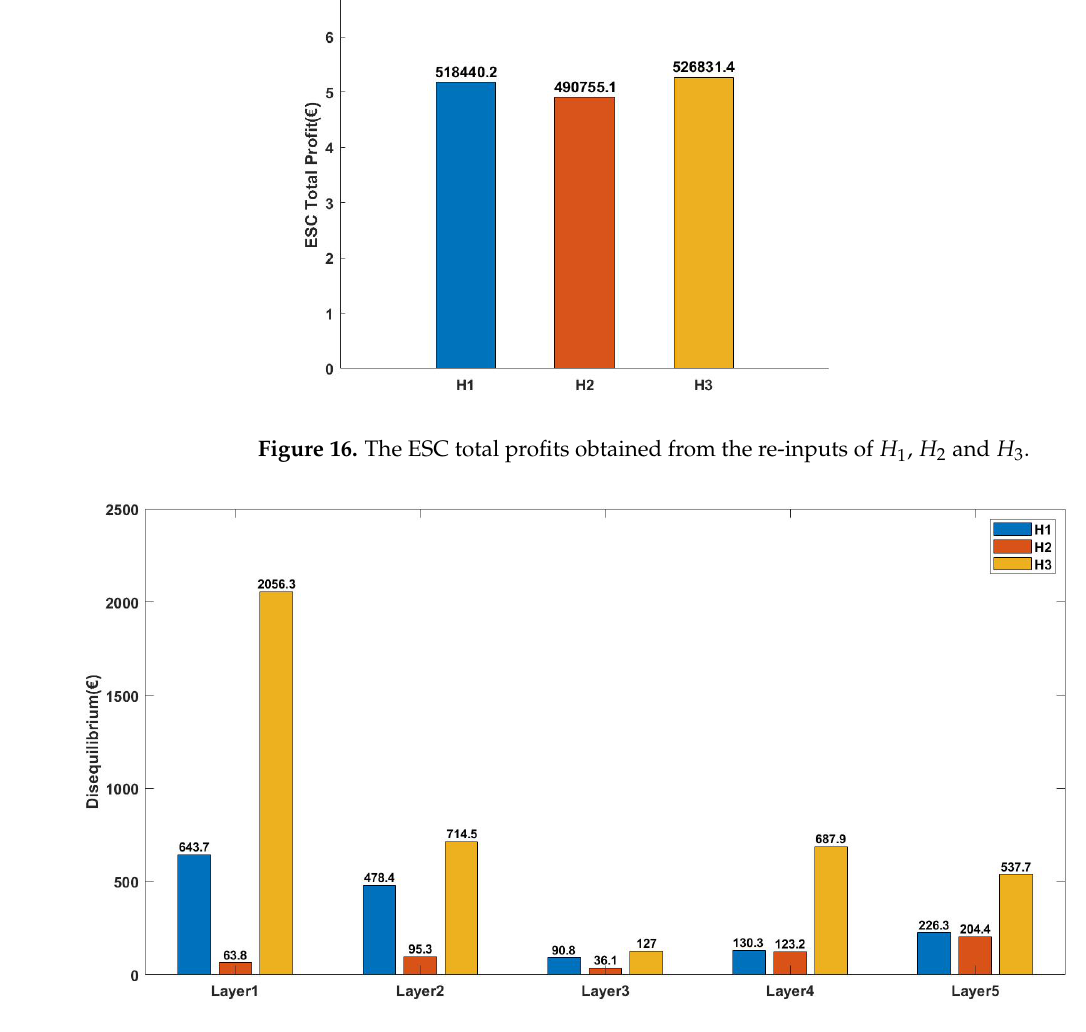
Figure 17. The disequilibrium for each layer considering variables of H 1 , H 2 and H 3